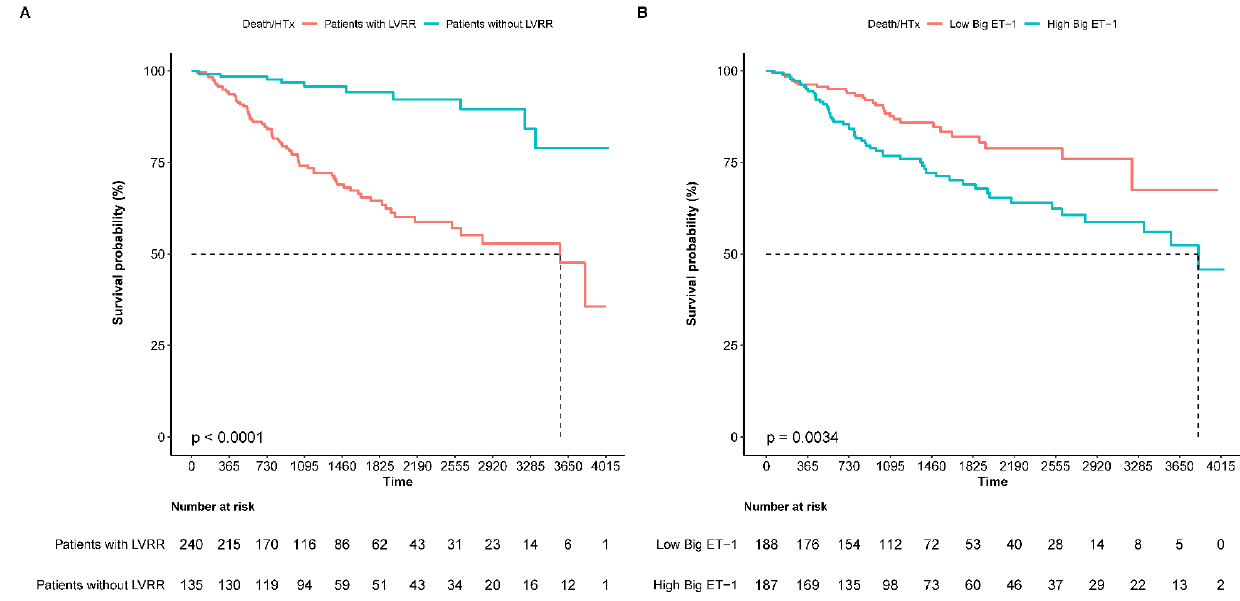
Figure 3. Comparison of the outcome between patients with LVRR (+) and LVRR ( − ) ( A ), and between patients with high Big ET-1 and low Big ET-1 ( B ). The high Big ET-1 was defined as the Big ET-1 above the median (0.72 pmol/L). Death/HTx: all-cause death or heart transplantations. Table 4. Independent predictors for the composite of all-cause death and heart transplantations. Crude